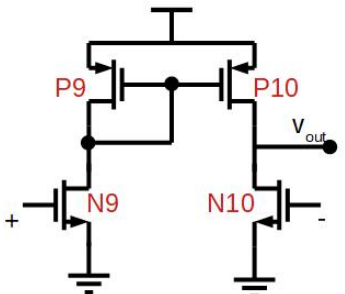
Figure 10. Amplifier A1.